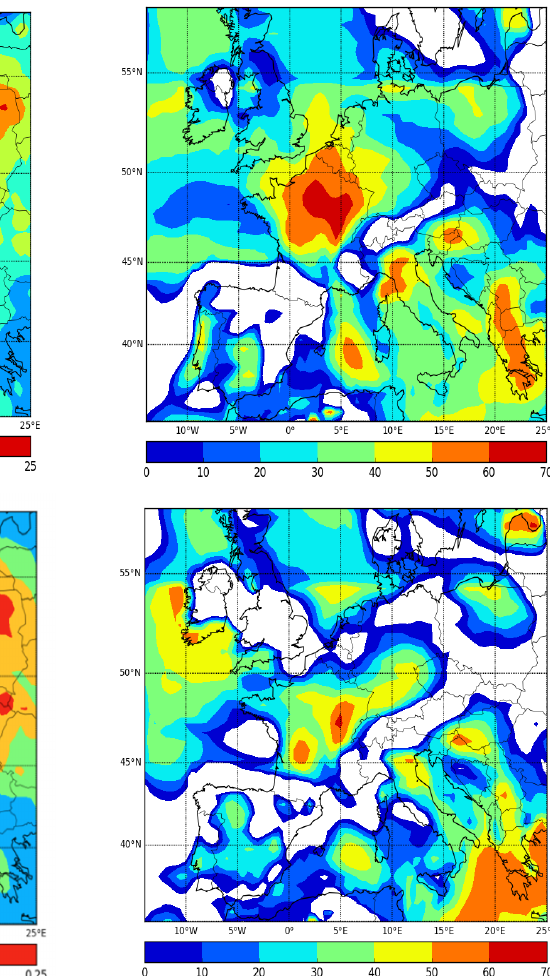
Table 3. Statistics of model to AirBase measurements comparisons for hourly PM 2.5 concentrations during March 2009. s and RMSE are expressed in µ g · m − 3 . Simulation without D.A. Simulation with